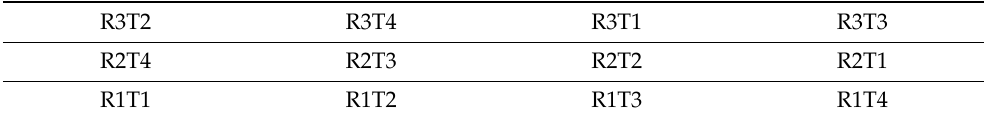
Table 1. RCBD layout plan of the study area.